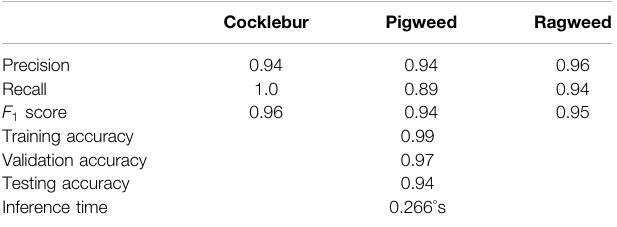
Cocklebur Pigweed